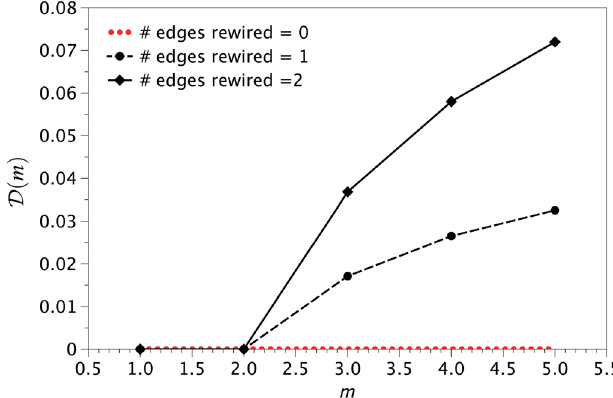
FIG. 16. Scenario 6. Normalized Kullback-Leibler divergence D ð m Þ between X ð t Þ and its Markovianized surrogate Y ð t Þ for a two-layer multiplex, where the second layer is a replica of the first layer in which a number of edges have been rewired. When no edges have been rewired, both replicas are identical, X ð t Þ is Markovian, and D ð m Þ ¼ 0 ∀ m ; otherwise, the process is non- Markovian, and the algorithm detects multiplexity by finding D ð m > 2 Þ > 0 . Such detection improves as the topology of both layers is increasingly different.